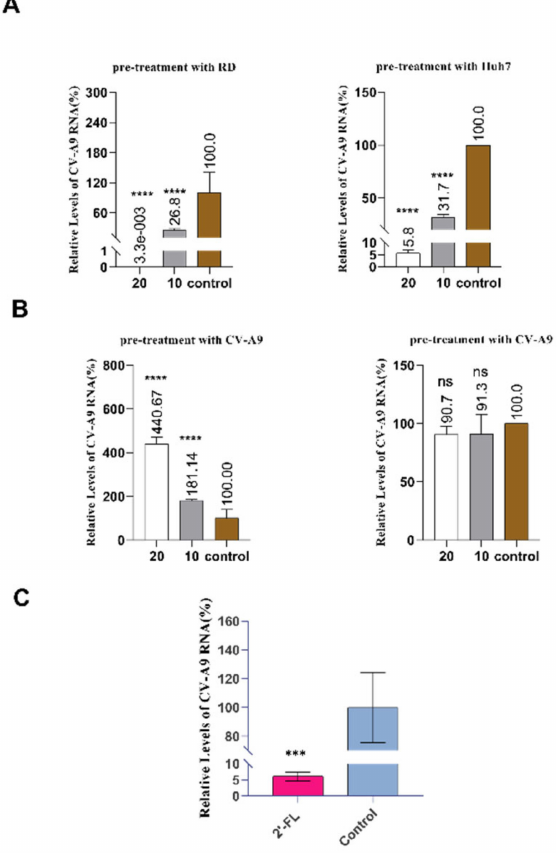
Figure 3. 2’-FL acts on cells to block infection. ( A ) Cells were incubated with 2 (cid:48) -FL at a final concentration of 20 mg/ml and 10 mg/ml for 4 h at 37 °C, followed by CV-A9 infection (MOI =